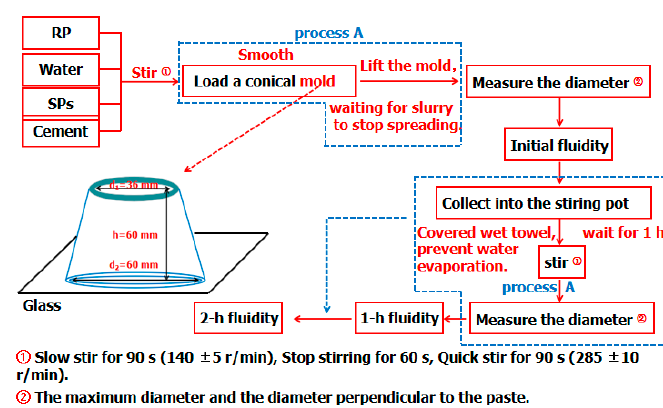
Figure 3. Experimental process of the RP impact on the cement and superplasticizer (CCS).